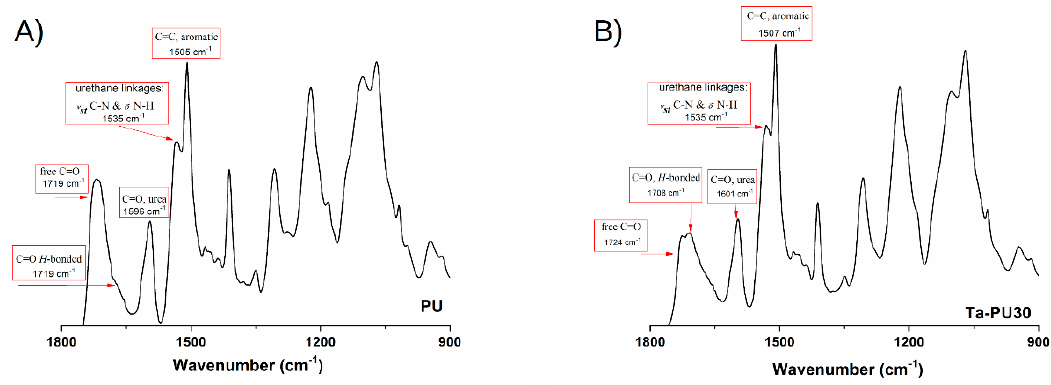
Figure 3. FTIR spectra of ( A ) pristine PU and ( B ) TaPU-30.